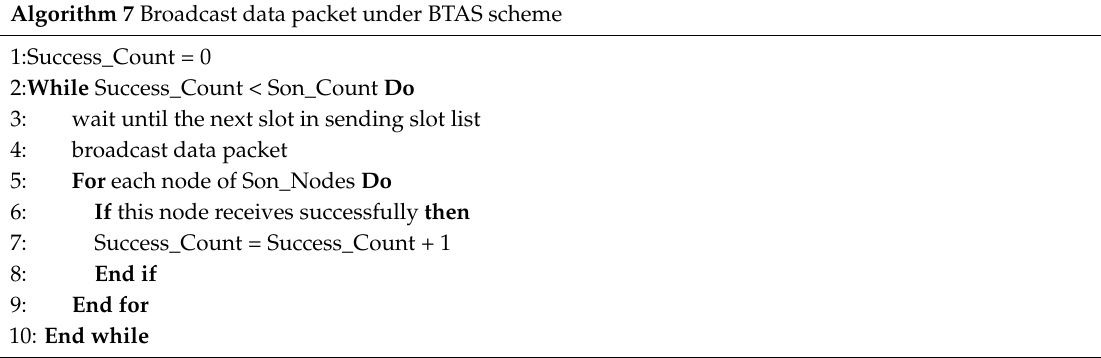
Algorithm 7 Broadcast data packet under BTAS scheme